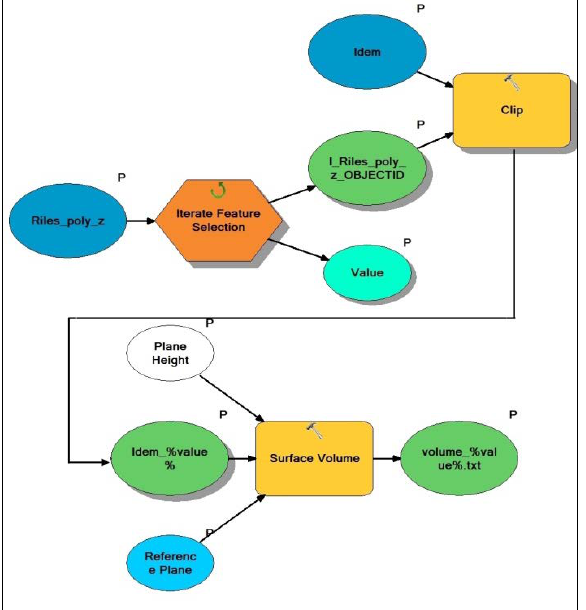
Figure 2. The algorithm of the calculation of volumes of planetary volcanic